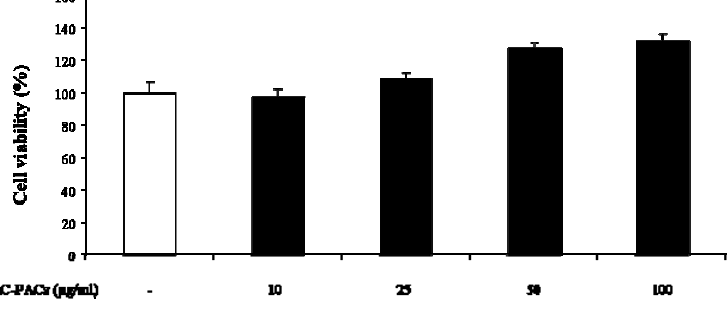
Figure 2. Cytotoxic effect of AC-PACs on osteoclastic cells as measured by the MTT